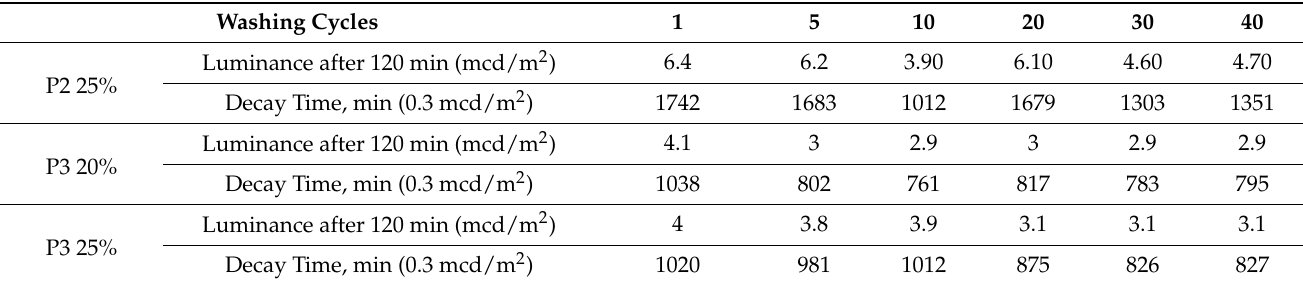
Table 6. Luminance decay obtained by samples coated with 25% of P2 pigment; 20 and 25% of P3 pigment after 1, 5 10, 20, 30 and 40 washing cycles (40 ◦ C, 40 min).